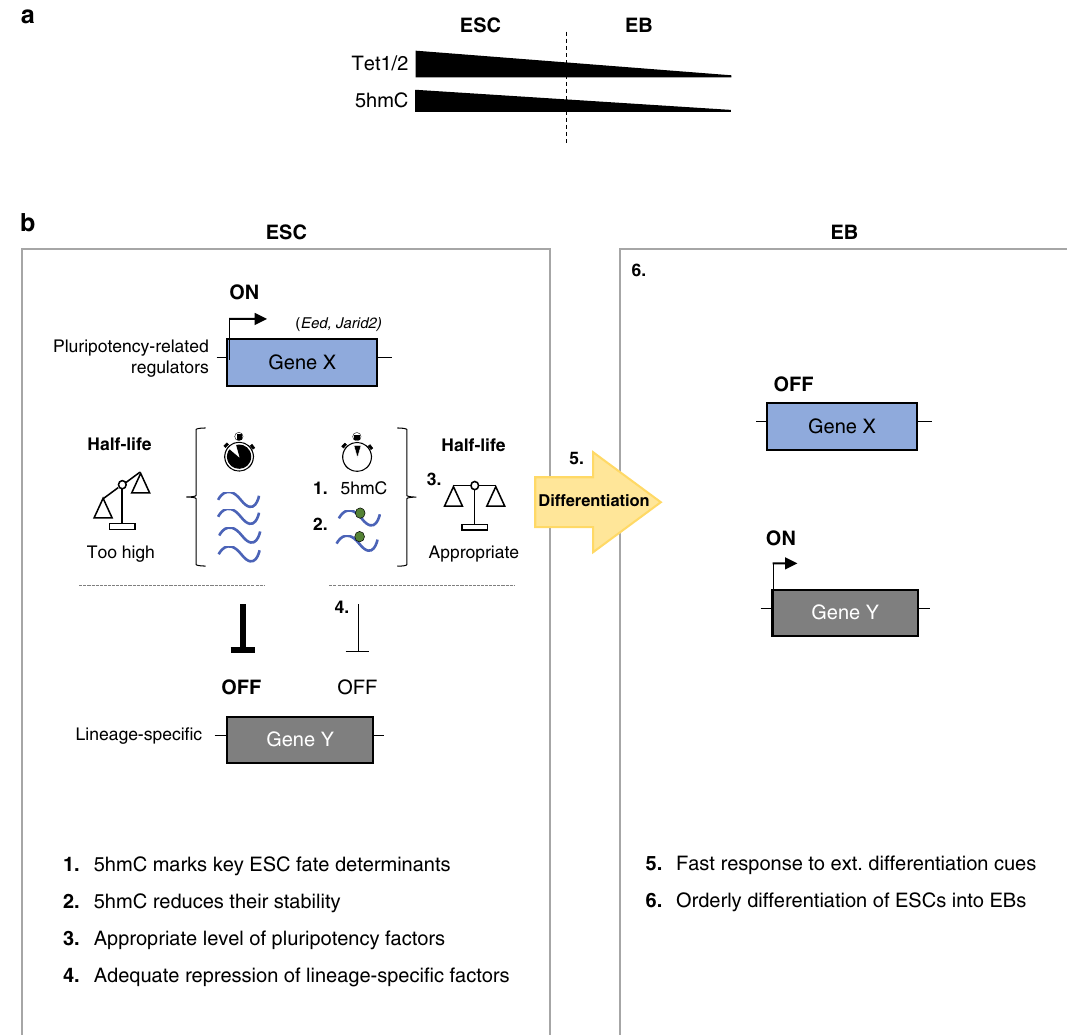
Fig. 7 Model of Tet-mediated 5hmC as a mark of transcriptome fl exibility in ESCs. a Scheme illustrating that spontaneous ESC-to-EB differentiation leads to reduced Tet1 and Tet2 expression and to a marked decrease in 5hmC. b 5hmC mRNA modi fi cation acts as an essential regulatory layer to